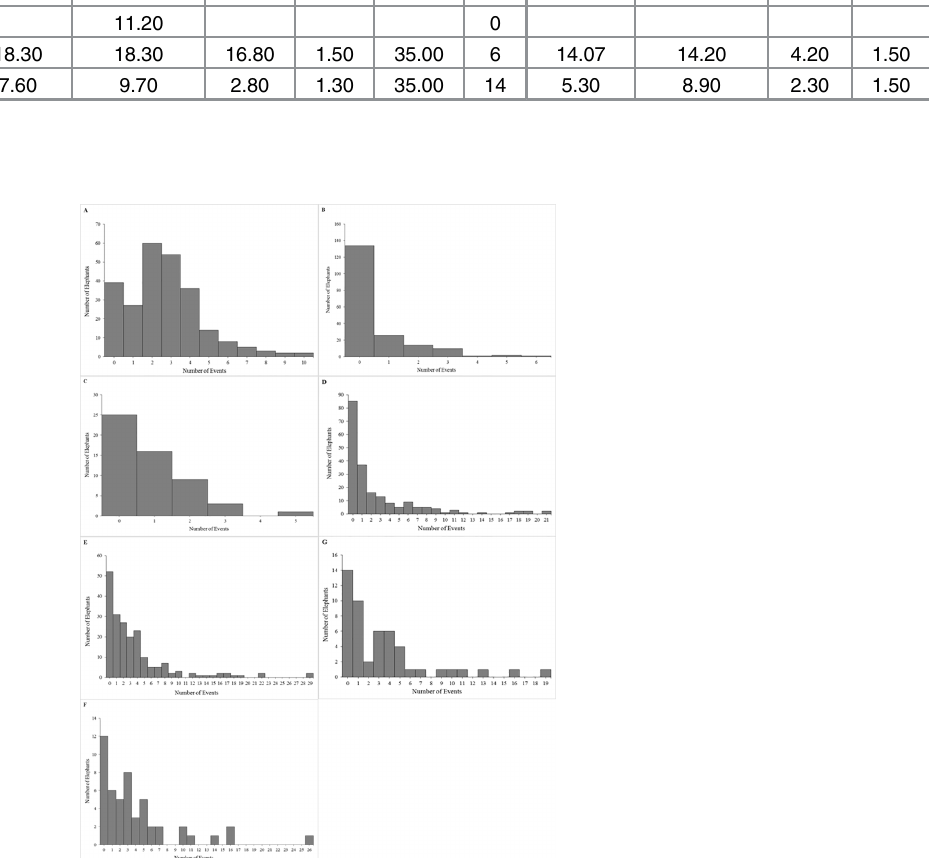
Fig 1. Summary of event frequencies for the study population of African and Asian elephants in North American zoos. Frequency of number of elephants experiencing (A) Transfers, (B) Offspring births – females, (C) Offspring Deaths – females, (D) Birth exposures – females, (E) Death exposures – females, (F) Death exposures – males, and (G) Birth exposures – males. Bins include no experience/exposure (0 events).